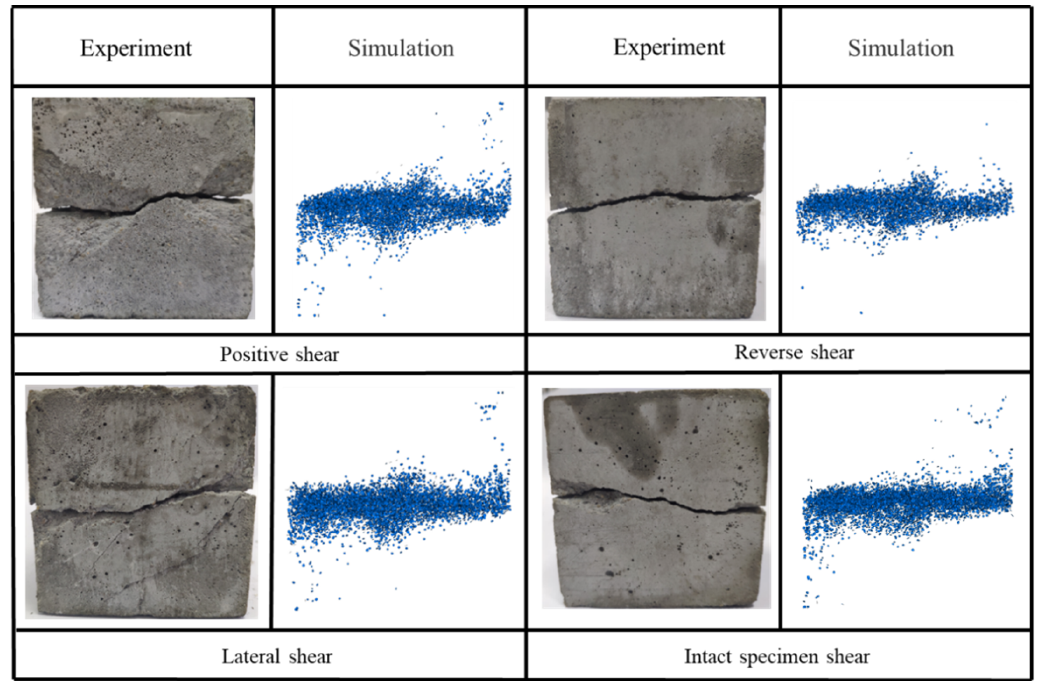
Figure 13. Comparison between the numerical value for the four groups of samples after failure and the failure surface of the physical test.